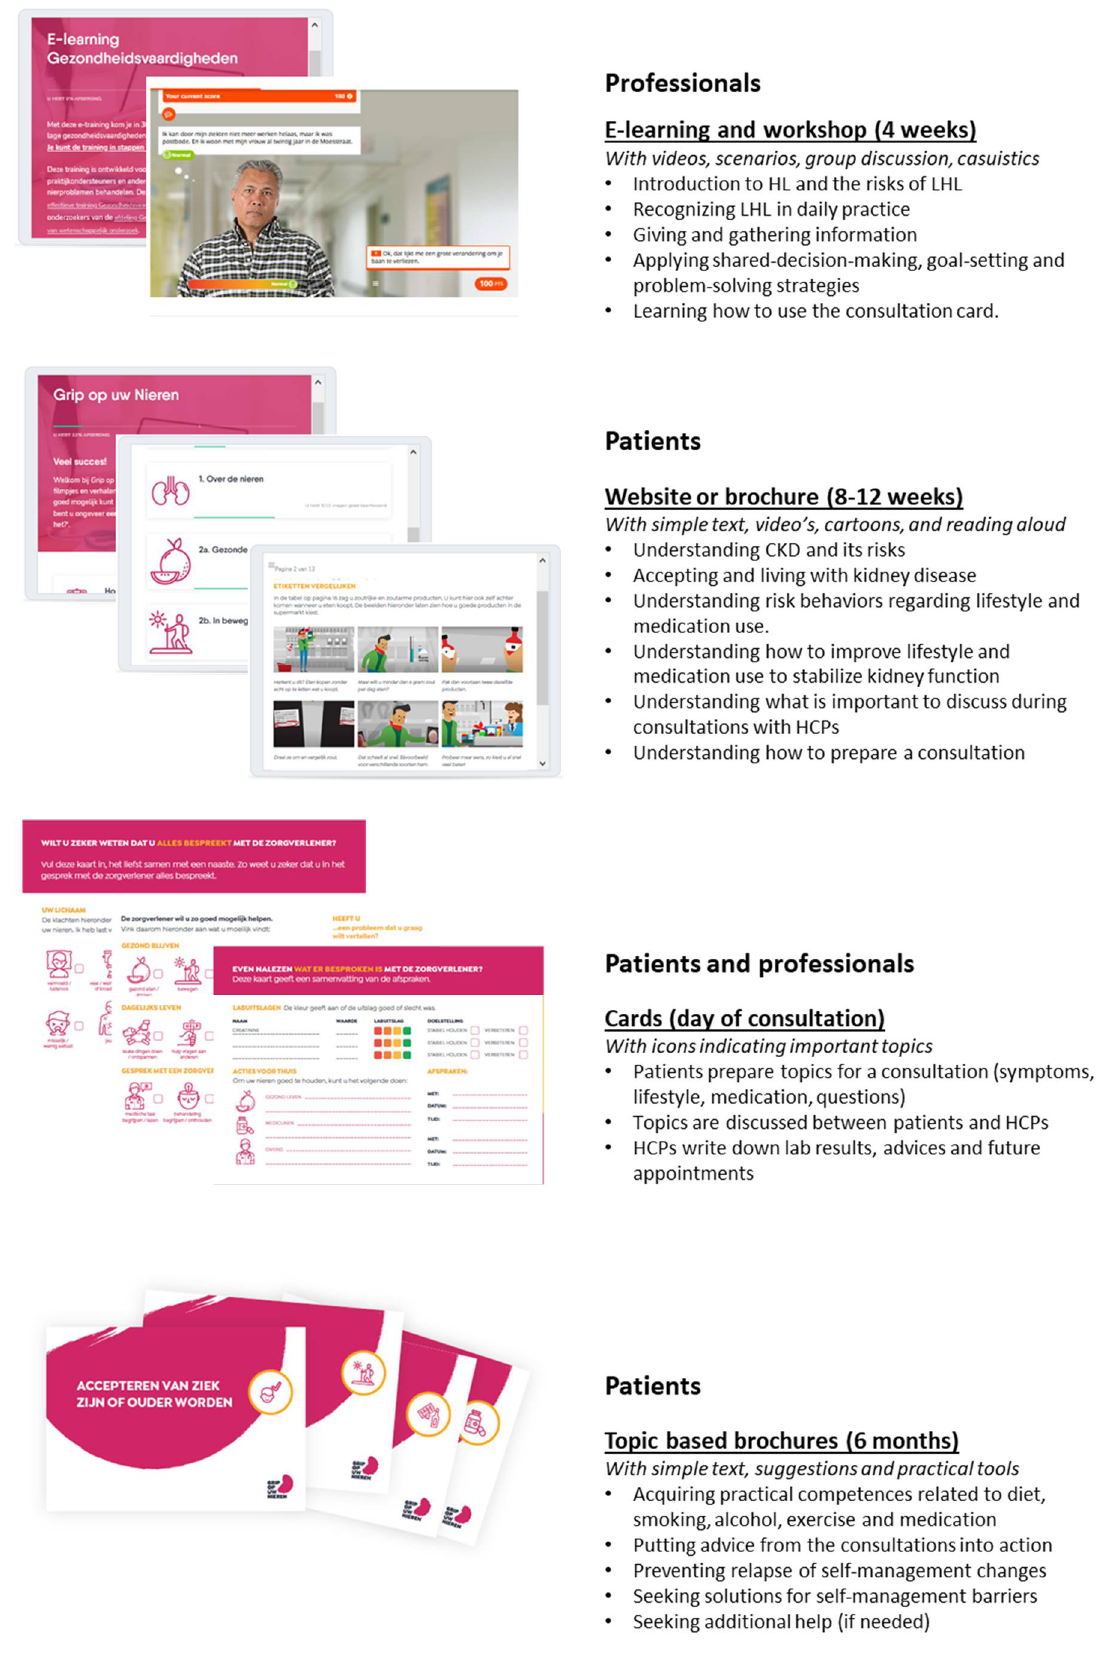
Figure 2. Overview of the final co-created four-component intervention.